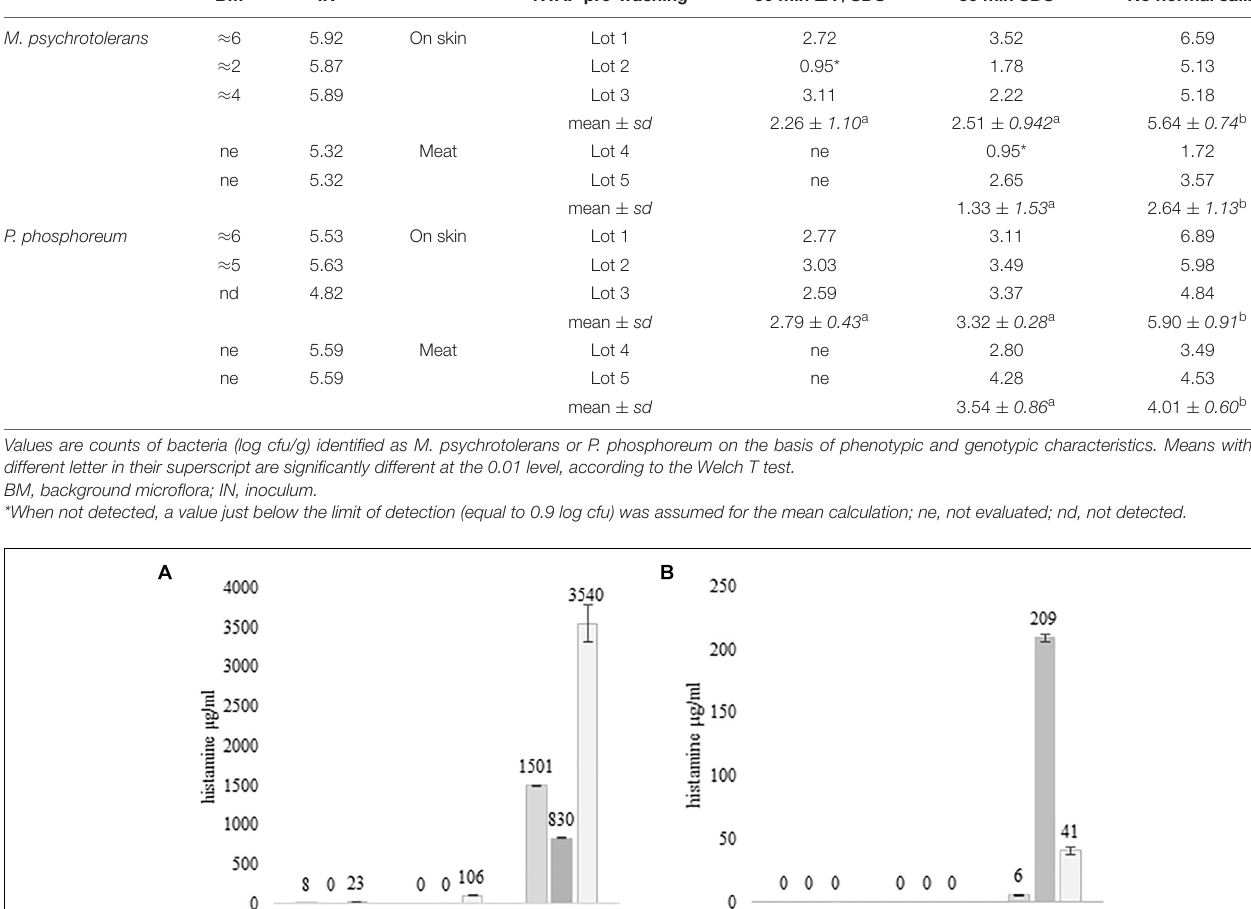
TABLE 2 | Inactivation of M. psychrotolerans and P. phosphoreum by non-thermal plasma associated with SDS and Lactic acid. BM IN NTAP pre-washing 30 min LA + SDS 30 min SDS No normal saline M.